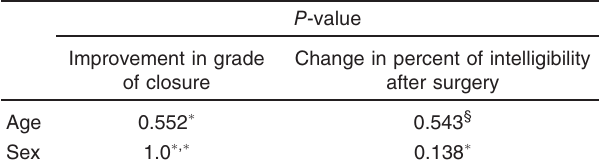
Table 4 Correlations between demographic data and improvement in grade of closure and change in percent of intelligibility after